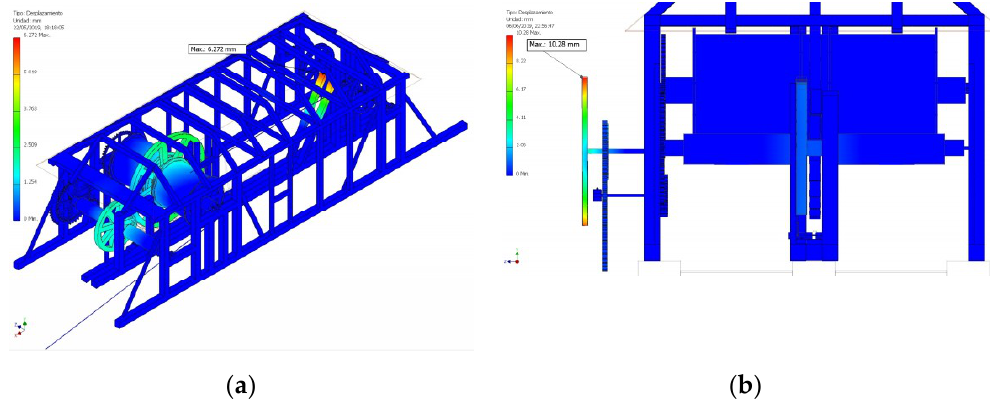
Figure 26. Location of the second highest displacement: ( a ) blockage situation and ( b ) braking situation.